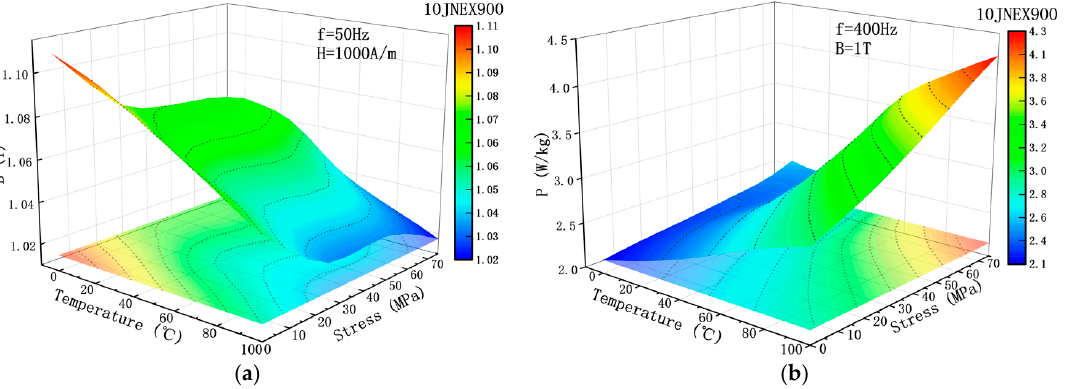
Figure 6. Effect of tensile stress on magnetic properties of two silicon steels at 25 °C. ( a ) B-H curve. ( b ) B-P curve.